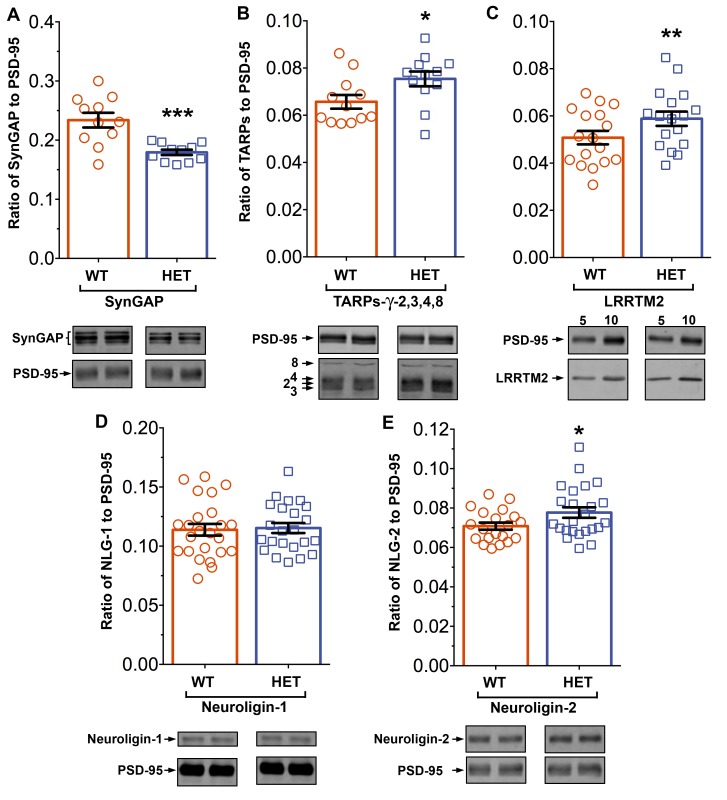
Altered composition of the PSD in mice with heterozygous deletion of synGAP.Ratios of amounts of the indicated proteins to PSD-95 in each lane were measured as described in 'Materials and methods' and are reported as mean ± S.E. For all blots except those for neuroligin-1, PSD-95 was detected with a secondary Ab labeled with AlexaFluor680 and the binding protein was detected with secondary Ab labeled with IRDye 800. On the neuroligin-1 blot, both PSD-95 and neuroligin-1 were detected with AlexaFluor680; the two bands were well-separated in each lane. Representative sets of visualized bands for WT and HET from the same blot are shown below the graphs. Individual points represent the ratio of the indicated protein to PSD-95 in a single lane (n refers to these technical replicates). The WT and HET PSD preparations were each made from six animals; thus, each of the two preparations represents six biological replicates. (A) SynGAP to PSD-95 ratio. Data were collected for 22 lanes from two blots containing 5 µg total PSD fraction per lane. One blot contained six lanes WT and six lanes HET samples, the other contained five lanes of each. The mean ratio of synGAP to PSD-95 was 0.234 ± 0.012 for WT (n = 11) and 0.179 ± 0.005 (n = 11) for HET (−24%). Means were compared by unpaired, one-tailed t-test with Welch correction, p = 0.0007. Effect size, d = 1.75. (B) TARP ɣ -2,3,4,8 to PSD-95 ratio. Data were collected for 24 lanes from two blots containing 10 µg total PSD fraction per lane. Each blot contained six lanes WT and six lanes HET samples. Densities of all four TARPs were pooled. The mean ratio of TARPs to PSD-95 was 0.066 ± 0.003 (n = 12) for WT and 0.075 ± 0.003 (n = 12) for HET (+12%). Means were compared by unpaired, one-tailed t-test with equal variance, p = 0.017. Effect size, d = 0.93. (C) LRRTM2 to PSD-95 ratio. Data were collected for 36 lanes from three blots containing six WT and six HET samples, alternating 5 and 10 µg (3 each). The mean ratio of LRRTM2 to PSD-95 was 0.051 ± 0.003 (n = 17) for WT and 0.059 ± 0.003 (n = 17) for HET (+14%). Means were compared by paired, one-tailed t-test, p=0.0035. Effect size, d = 0.66. (D) Neuroligin-1 to PSD-95 ratio. Data were collected for 47 lanes from four blots two of which contained 5 µg and two 10 µg total PSD fraction per sample. Each blot contained 6 lanes WT and 6 lanes HET samples. The mean ratio of neuroligin-1 to PSD-95 was 0.114 ± 0.005 (n = 24) for WT and 0.115 ± 0.004 (n = 23) for HET (no difference). Means were compared by unpaired one-tailed t-test, p = 0.413. Effect size, d = 0.07. (E) Neuroligin-2 to PSD-95 ratio. Data were collected for 44 lanes from four blots containing 10 µg total PSD fraction per lane. Each blot contained six lanes WT and six lanes HET samples. The mean ratio of neuroligin-2 to PSD-95 was 0.071 ± 0.002 (n = 20) for WT and 0.078 ± 0.003 (n = 24) for HET (+9%). Means were compared by unpaired, one-tailed t-test with Welch correction, p=0.019. Effect size, d = 0.64. *p<0.005; **p<0.01; ***p<0.001DOI:
http://dx.doi.org/10.7554/eLife.16813.01910.7554/eLife.16813.020Figure 11—source data 1.Source data for ratios determined in Figure 11 A through E.